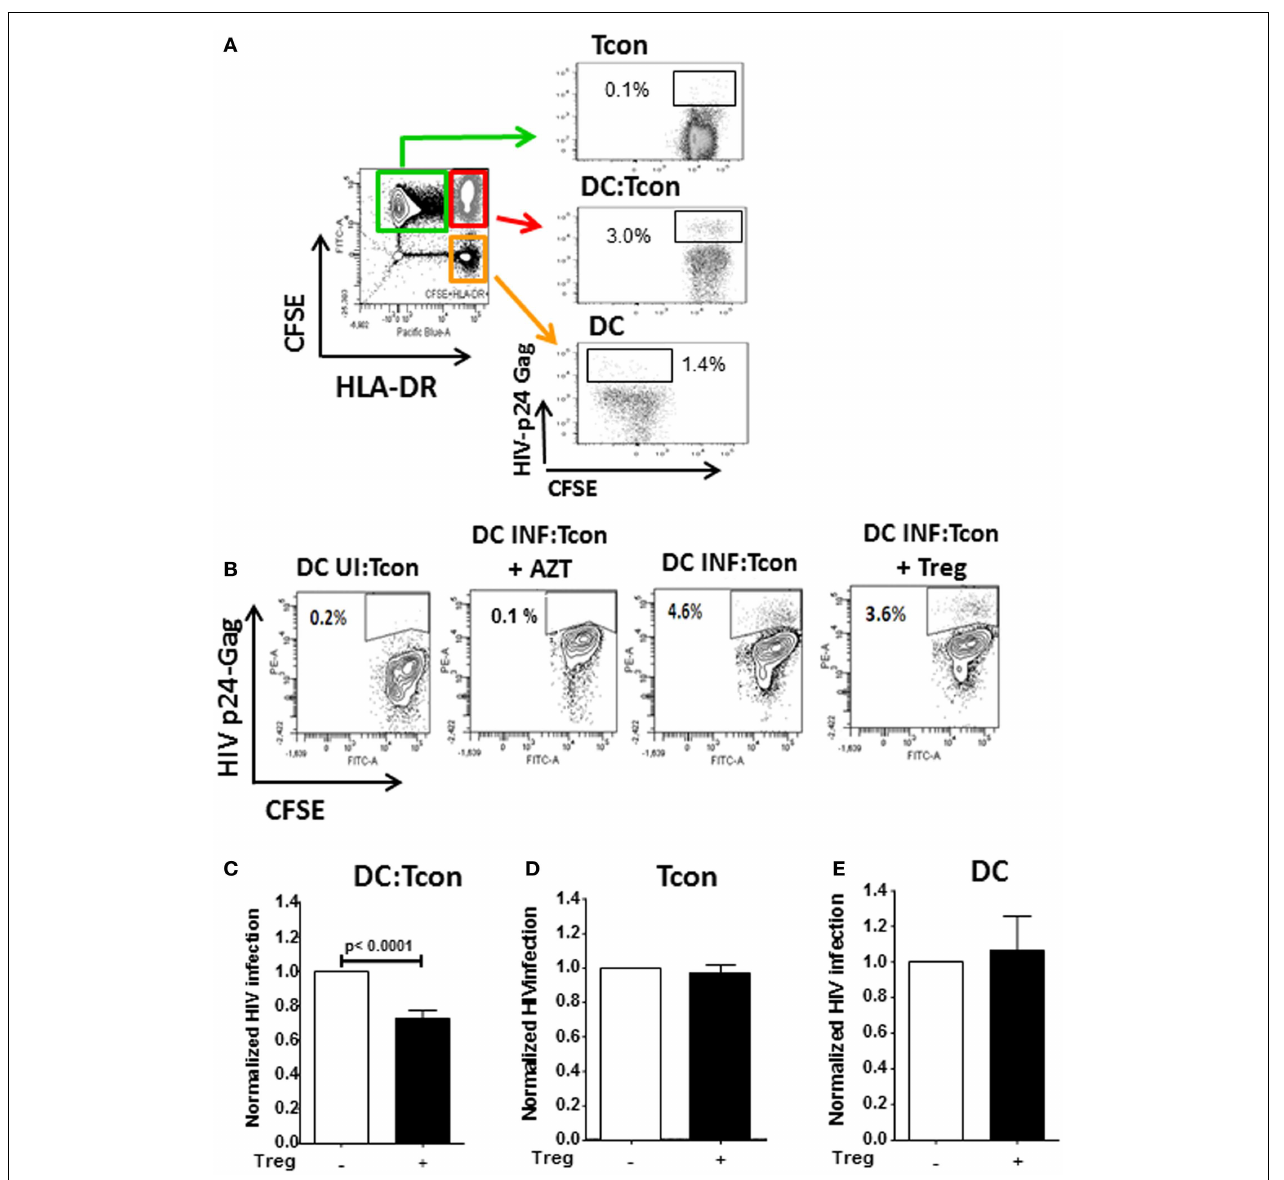
cytometry using the gating strategy described in (B) . Cultures containing AZT were used to set up the HIV-p24Gag + gate. One representative experiment is shown. Percentage of HIV-p24Gag + cells is indicated in each panel. UI, uninfected; INF, infected. (C–E) Summary of all experiments ( n = 12). (C) DC:Tcon clusters, (D) singleTcon, and (E) single DC. Normalized HIV infection was calculated based on the DC:Tcon cultures withoutTreg for each individual. Mean (SE) percent infection in DC:Tcon clusters,Tcon, and DC are shown. p Values correspond to paired t